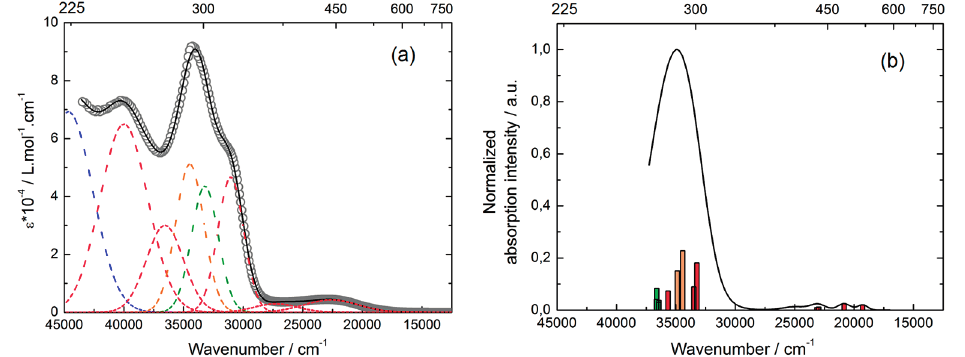
Figure 3. ( a ) Experimental UV-visible absorption spectra of L in CH 2 Cl 2 solution ( C = 4 × 10 − 5 mol·L − 1 ) (open grey circles). Respective Gaussian decompositions (red, orange, and blue dashed lines correspond to ILCT, intra-donor and intra-acceptor transitions, respectively) and best fit (full black line) ( R = 0.9994) ( b ) Theoretical absorption spectra of L (black line). The bars represent the mean contributions of the absorption spectra.